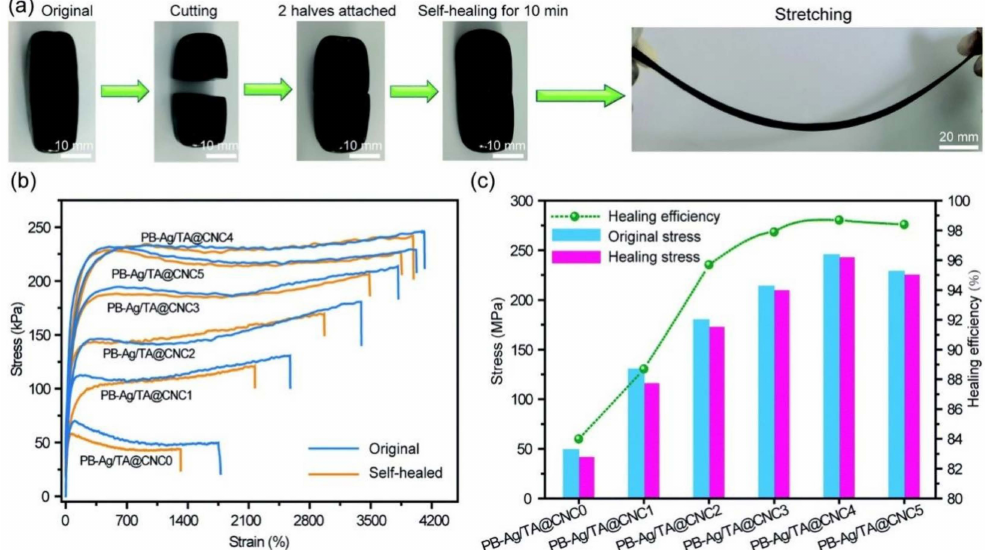
Figure 7. ( a ) Demonstration of the self-healing ability of PB-Ag/TA@CNC4 in an ambient environ- ment. ( b ) Tensile stress–strain curves of the PB-Ag/ TA@CNC hydrogels with different contents of Ag/TA@CNC before and after healing for 10 min. ( c ) Original stress, healed stress and corresponding self-healing efficiency of the PB-Ag/TA@CNC hydrogels. Reproduced from Ref. [67] with permission from the Royal Society of